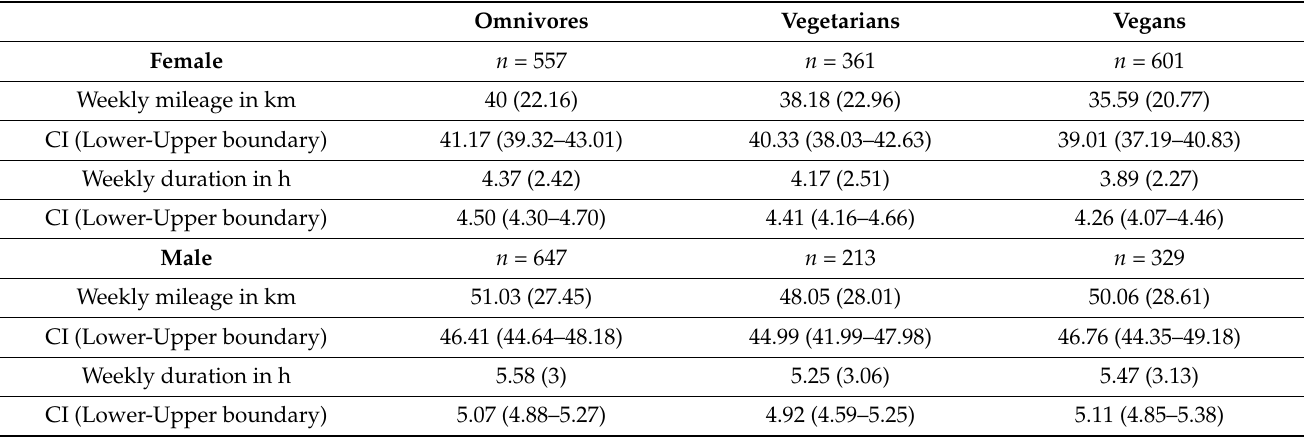
Table 4. Weekly mileage and duration of training in female and male runners, and their interaction with diet type subgroups.